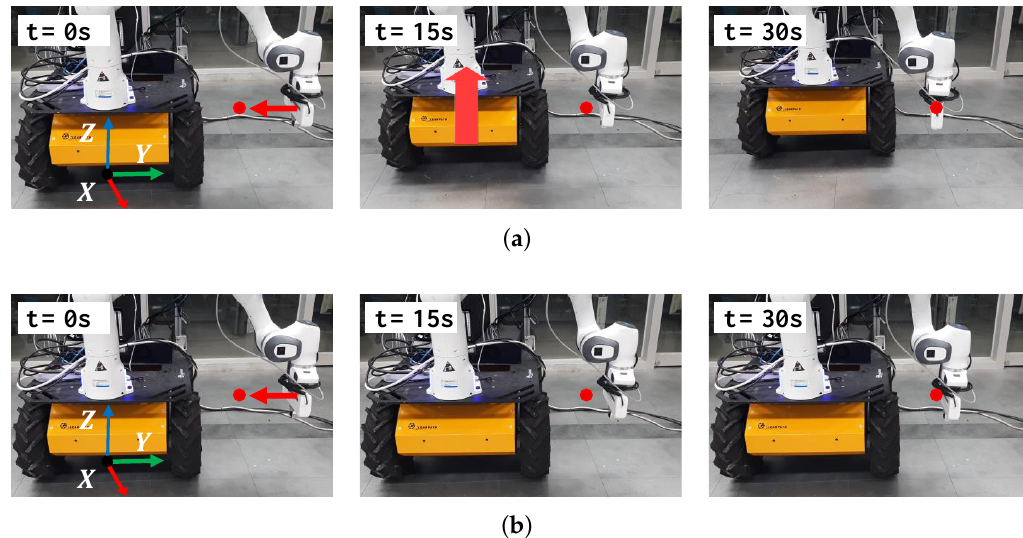
Figure 11. Snapshots during experiments in which the end-effector tracks a predefined trajectory: ( a ) The proposed method generates force to move the mobile robot back, enabling the manipulator to not only avoid self-collision but also reach the target position; ( b ) the repulsive-force based method pushes the manipulator from the mobile robot so that the manipulator cannot reach the target position.